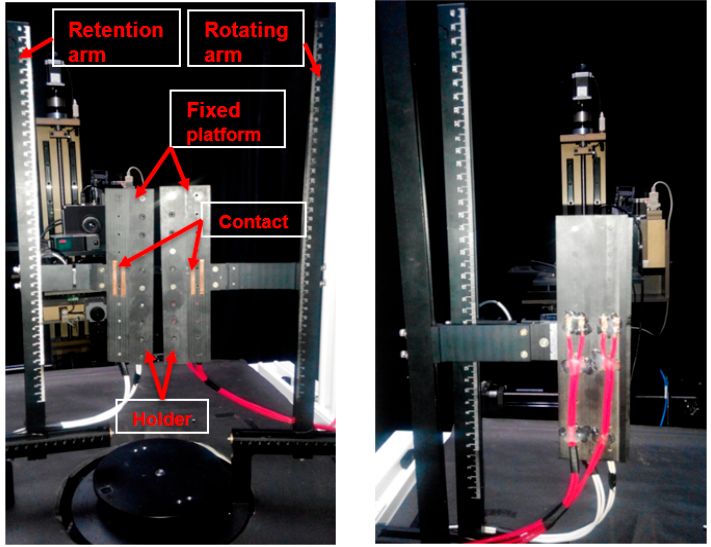
Figure 1. Flexible characteristic inspection system utilized in the patterned indium–tin–oxide/polyethylene terephthalate (ITO/PET) bending experiment.